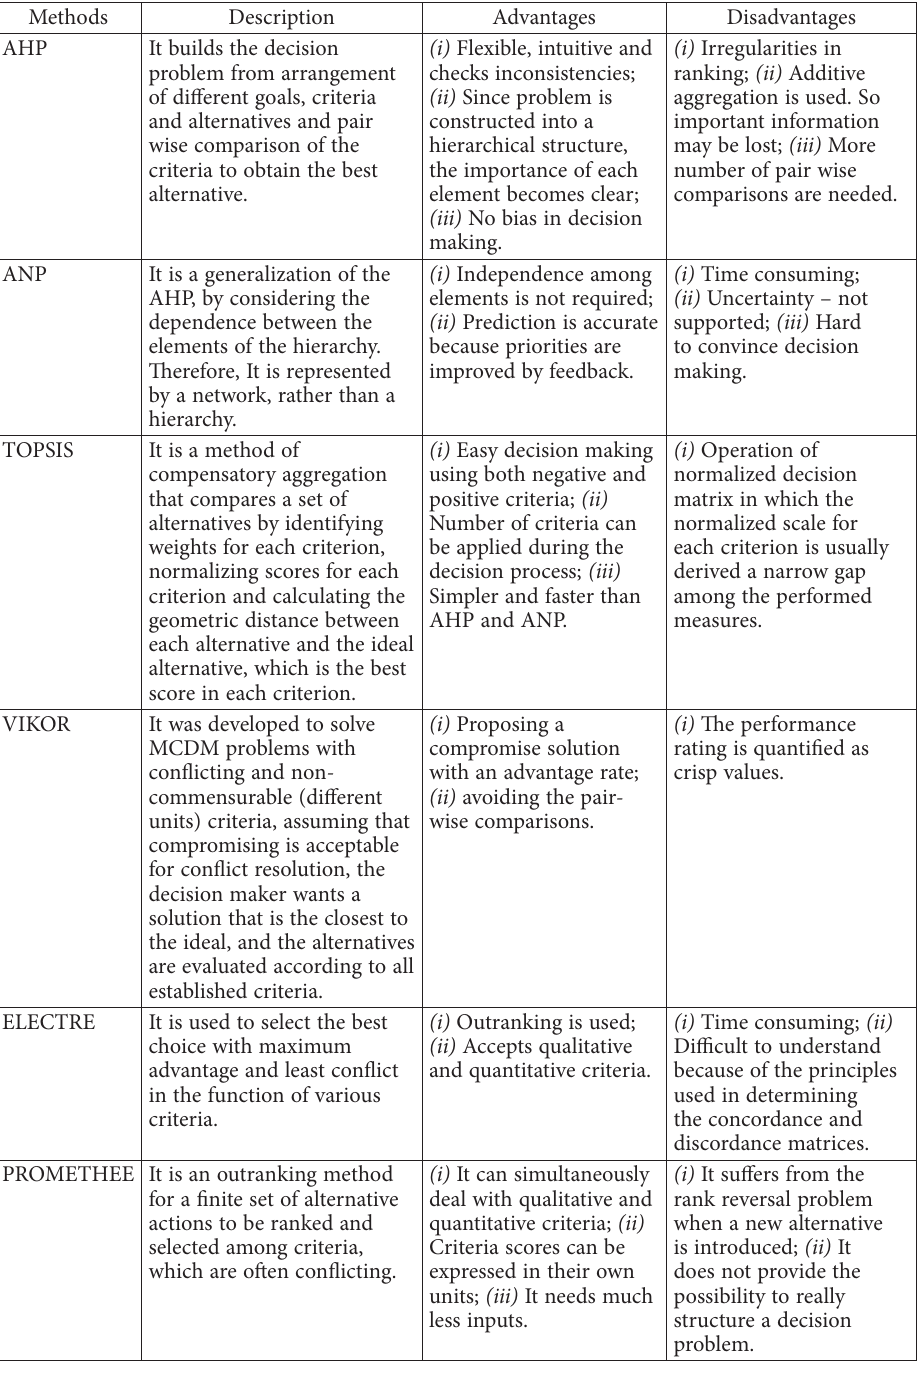
Table 2. MCDM methods with its merits and demerits (Aruldoss et al . 2013; Gavade 2014)